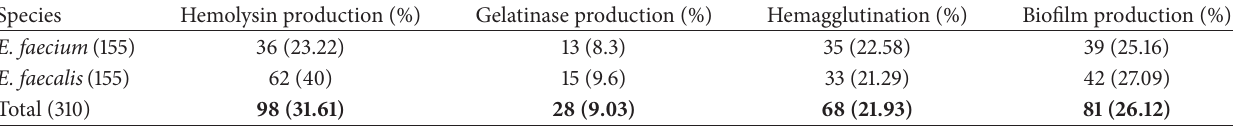
Table 1: Phenotypic detection of virulence factors in enterococcal isolates from clinical samples.